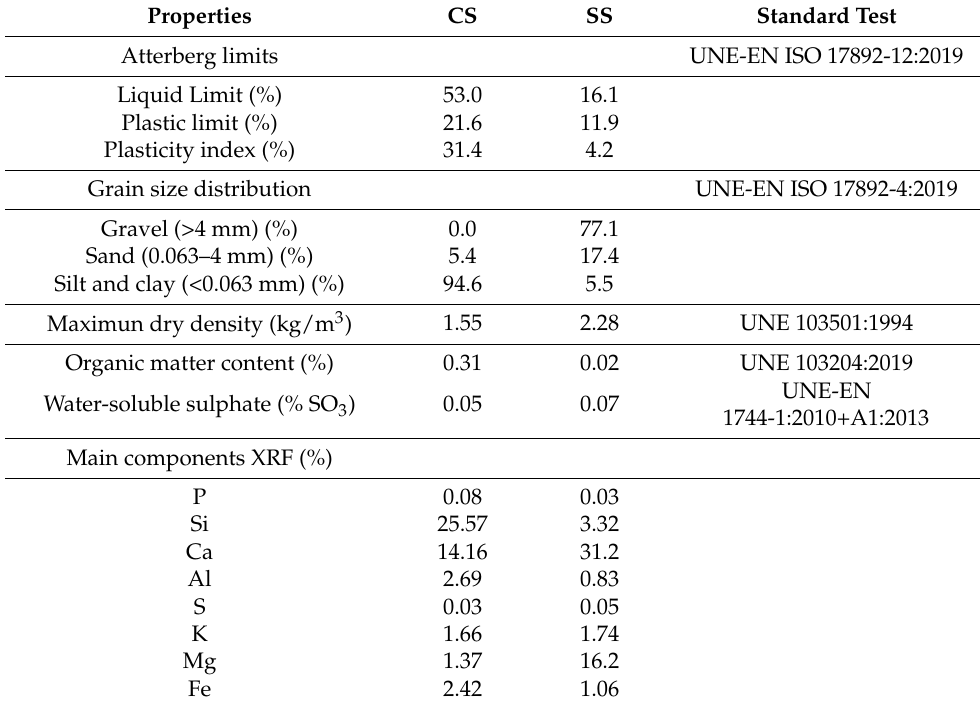
Table 1. Physical and chemical properties of CS and SS.